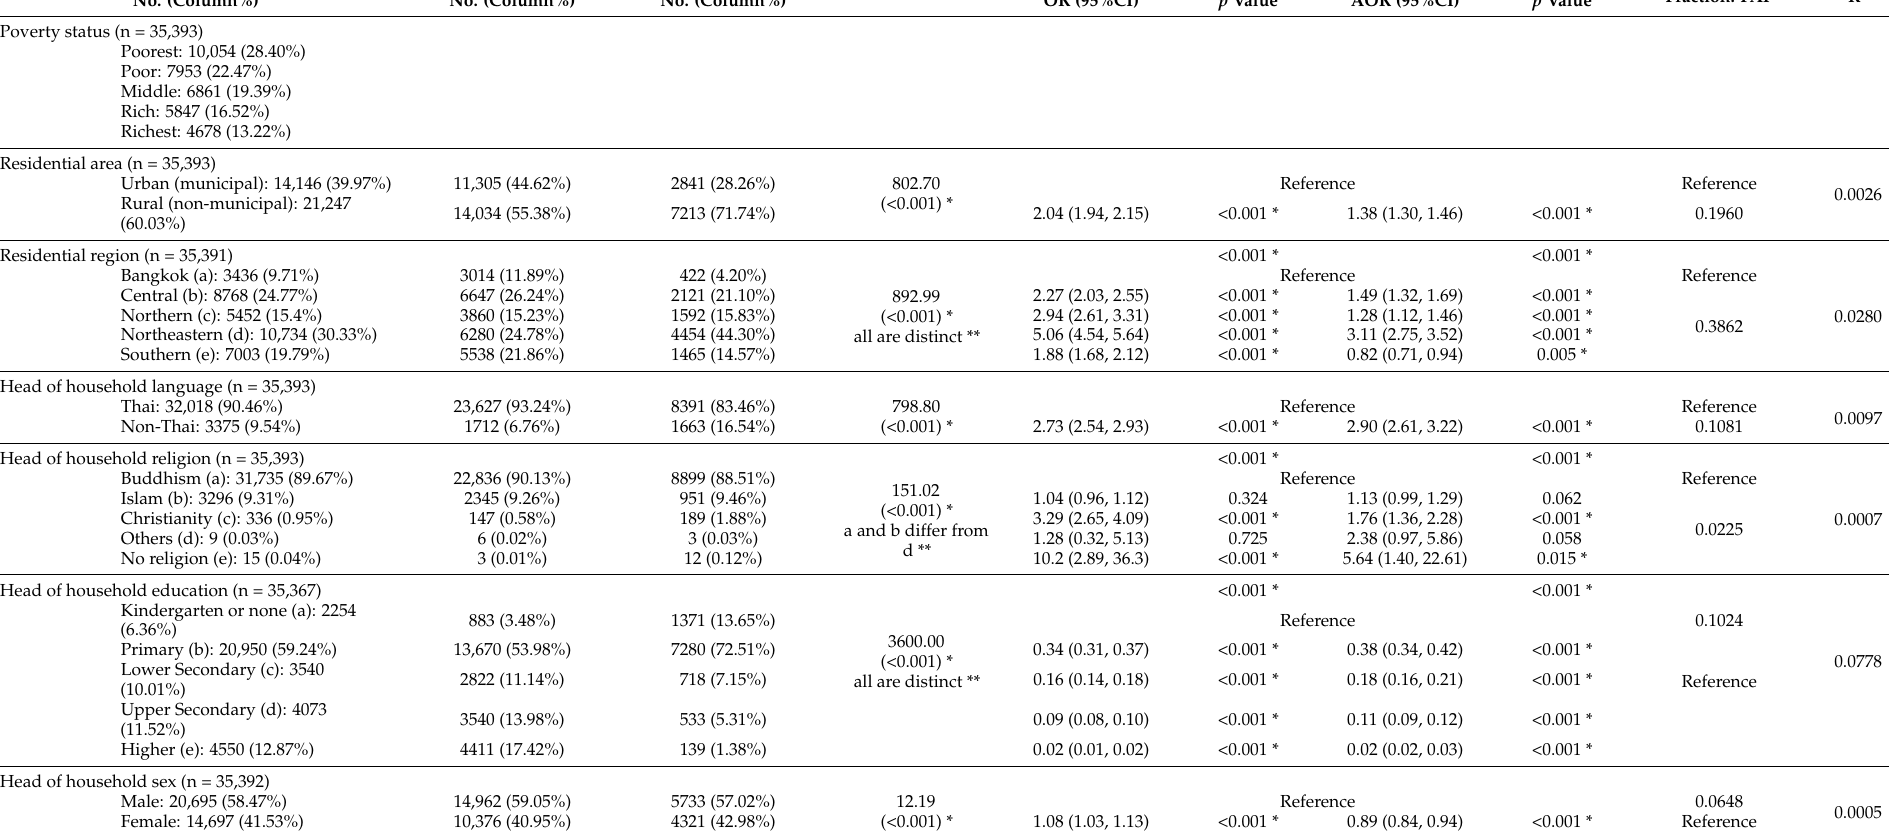
Different Attributable Pseudo Fraction: PAF R 2 No. (Column%) No. (Column%) No. (Column%) OR (95%CI) p Value AOR (95%CI) p